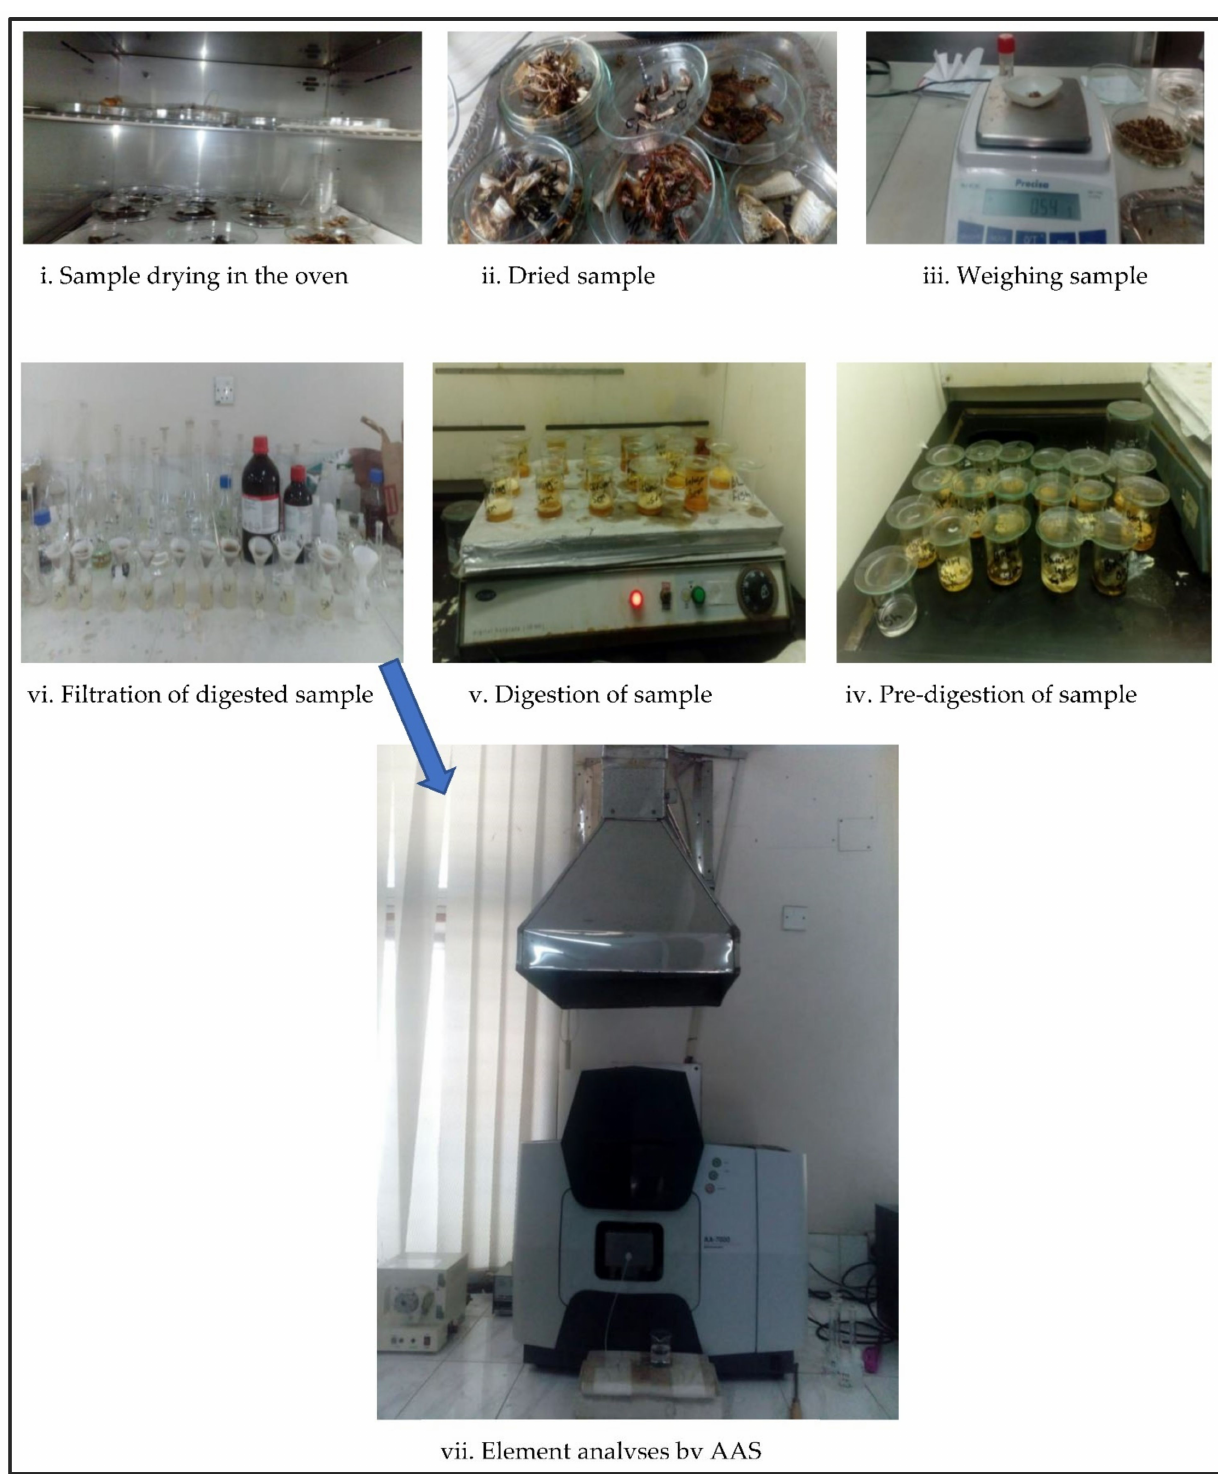
Figure 2. Main steps of heavy-metal analyses using